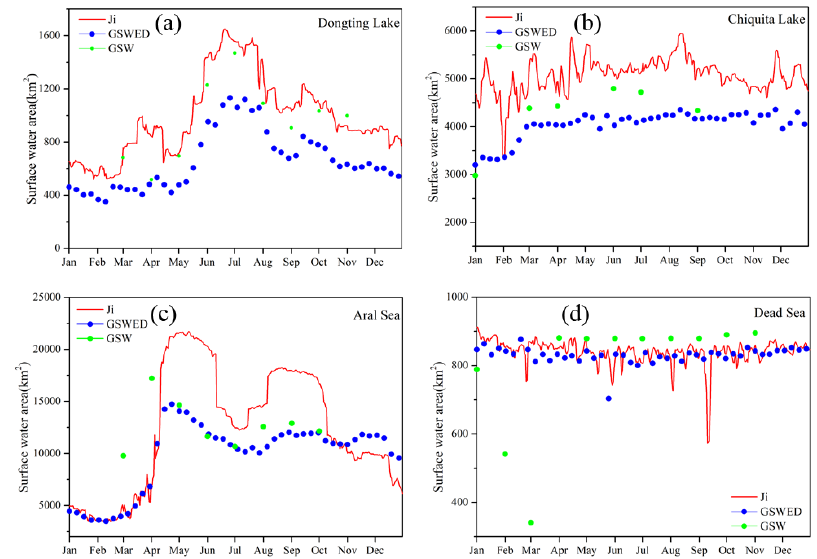
Figure 13. Changes in surface water area according to Ji [26], global surface water [25] and the global surface water extent dataset in Dongting Lake ( a ), Chiquita Lake ( b ), Aral Sea ( c ), and the Dead Sea ( d ) in 2015.